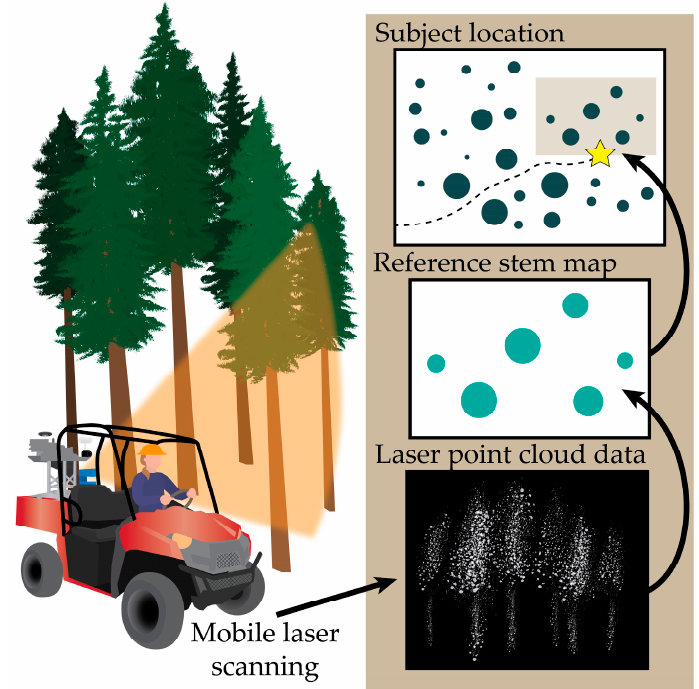
Figure 7. Simultaneous Location and Mapping (SLAM) techniques in the forest (based on Qian et al.) [7]. First, reference trees with known diameters must be mapped with their GNSS coordinates (not shown). Then, mobile laser scanning equipment (e.g. LiDAR) scans an area of interest in the woods (left). From the LiDAR point cloud data (bottom right), a stem distribution map is generated (middle right), which is compared to the reference tree map (top right) and in turn used to determine position. In practice, certainty in the map and location estimates improves with repeated passes and multiple perspectives.